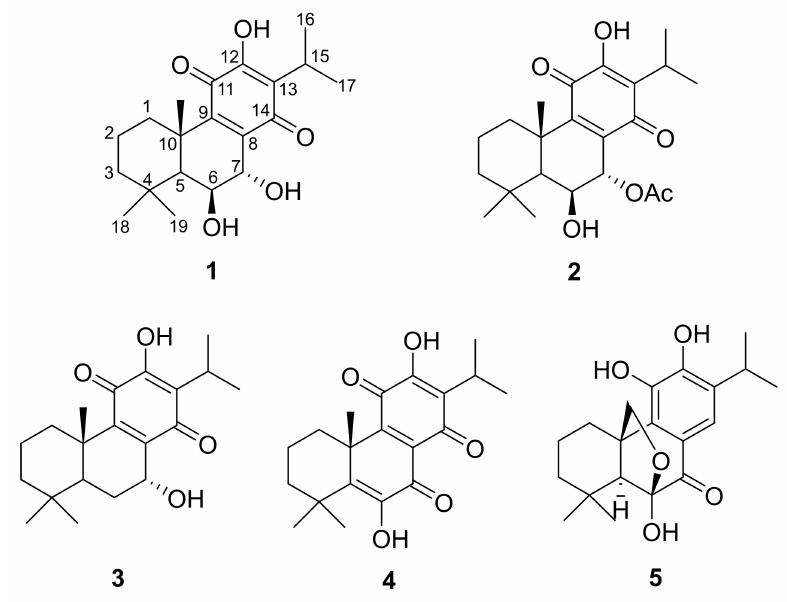
Figure 1. Chemical structure of compounds 1 – 5 isolated from P. madagascariensis